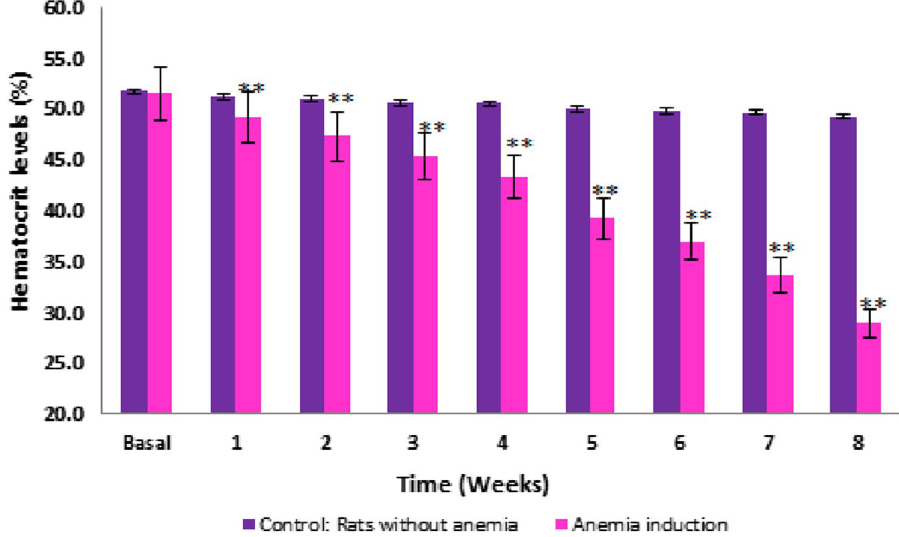
Fig. 1 Histopathological analysis of rat organs from the acute toxicity test when quinoa flour, the Negra Collana variety, is administered orally. A Stomach. B Lung. C Brain. D Kidney. E Liver